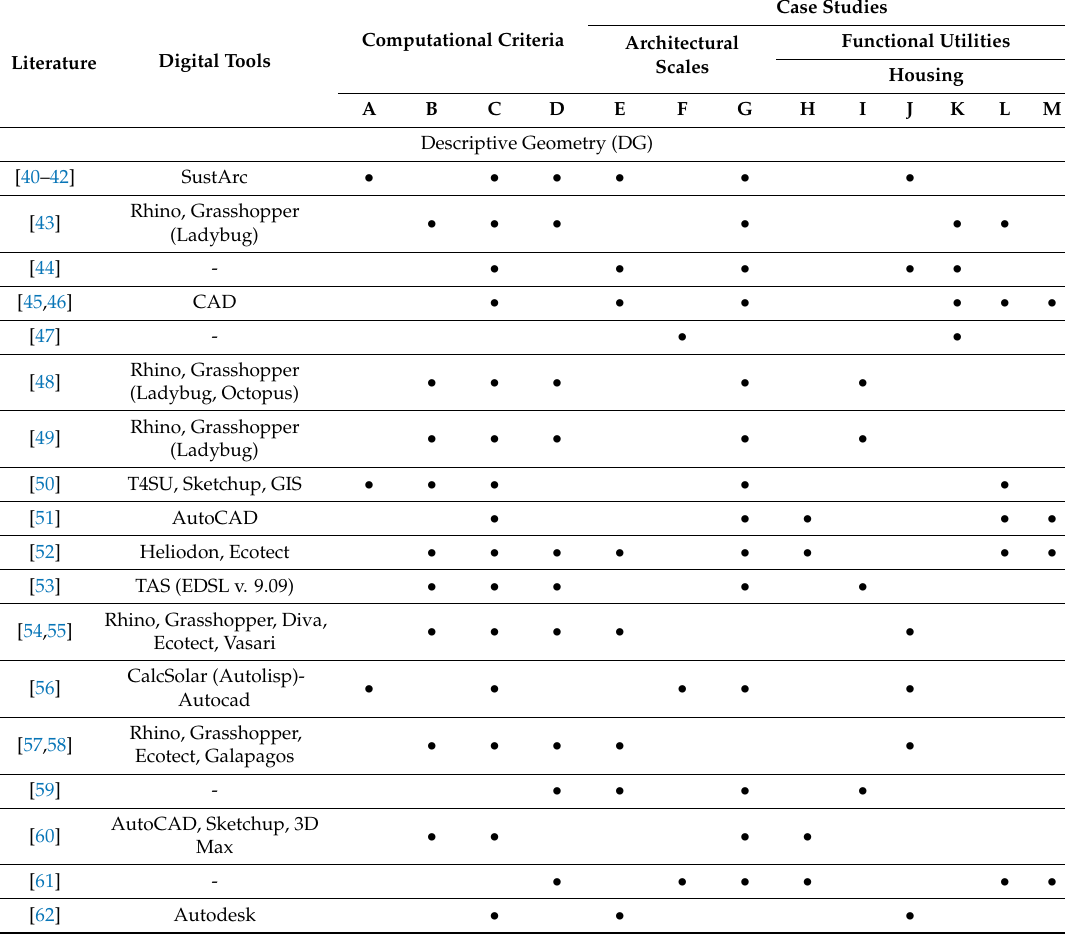
Table 2. Database of the computational environment parameters of solar envelopes based on the selected